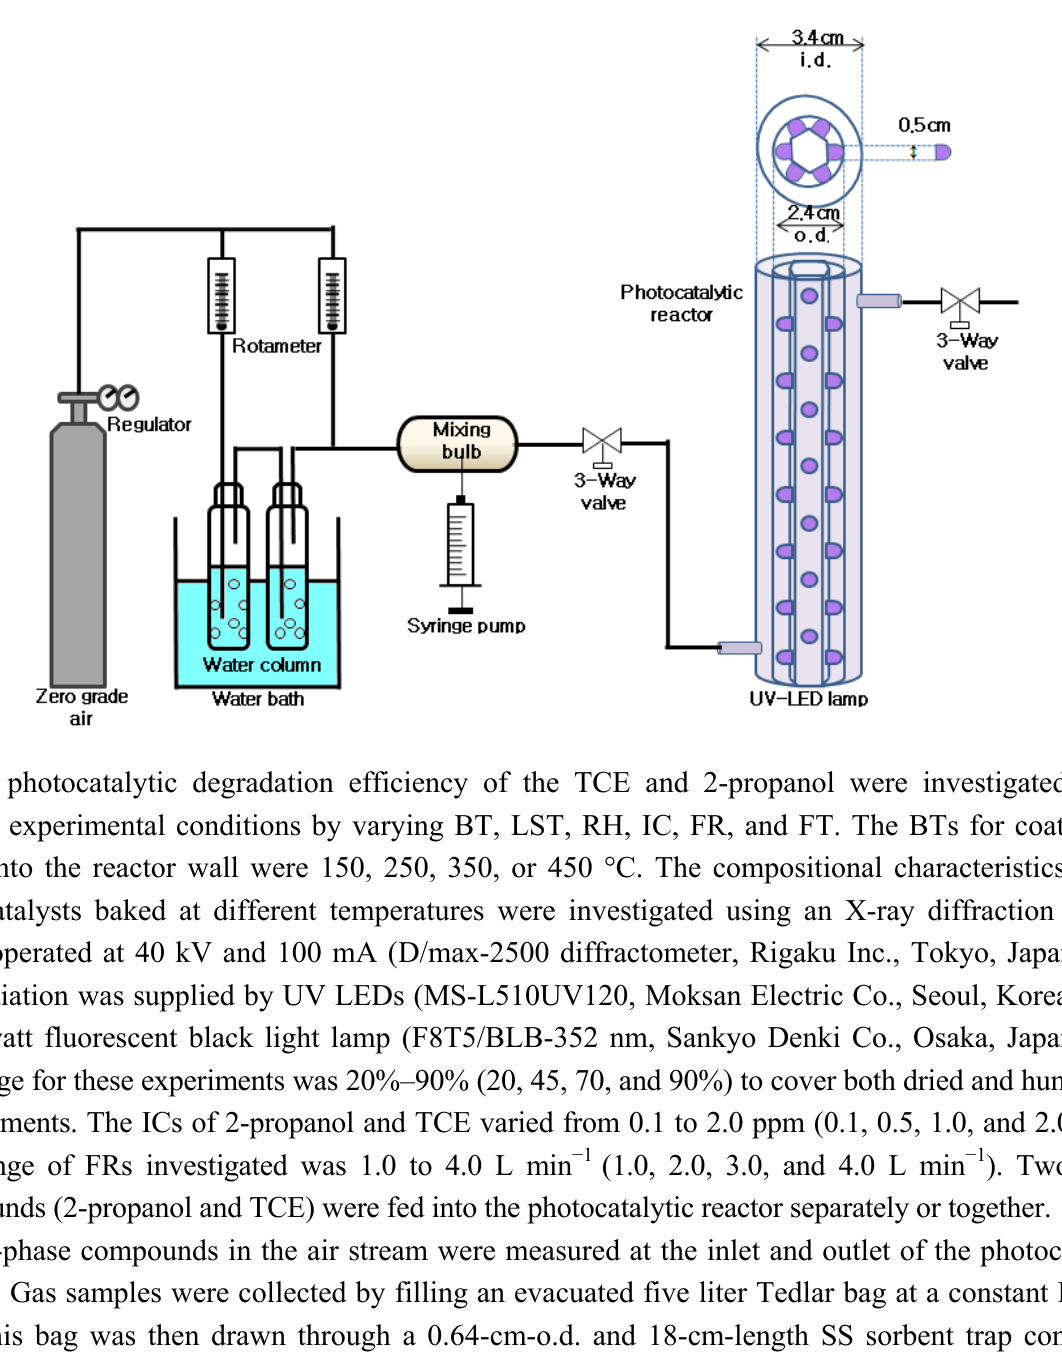
Figure 8. Schematic diagram of experimental